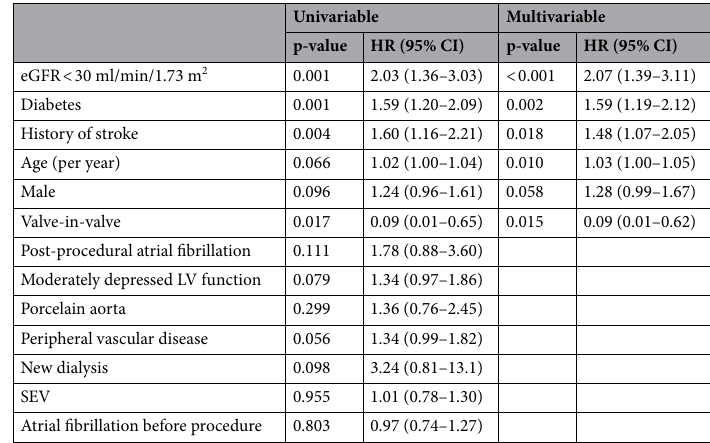
Table 1. Risk factors for developing a stroke after a successful TAVR. Univariable analysis include variables with a p < 0.100 and variables that could be of clinical interest. The multivariable analysis was constructed from a backwards elimination method. eGFR estimated Glomerular Filtration rate, SEV self-expandable